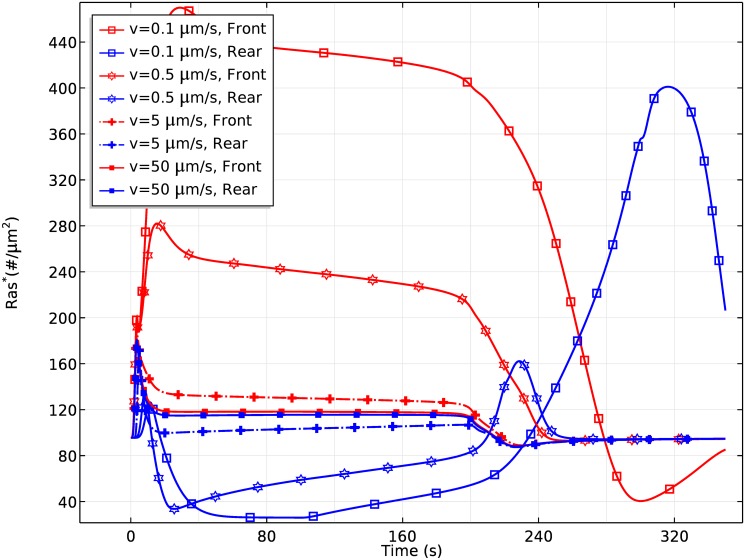
The time course of Ras activation at the extreme front and rear points for different wave speeds.